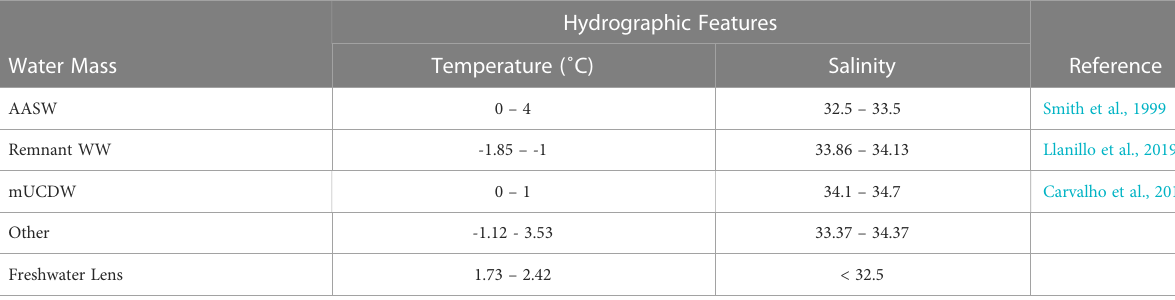
TABLE 3 Water mass features (temperature and salinity) during glider